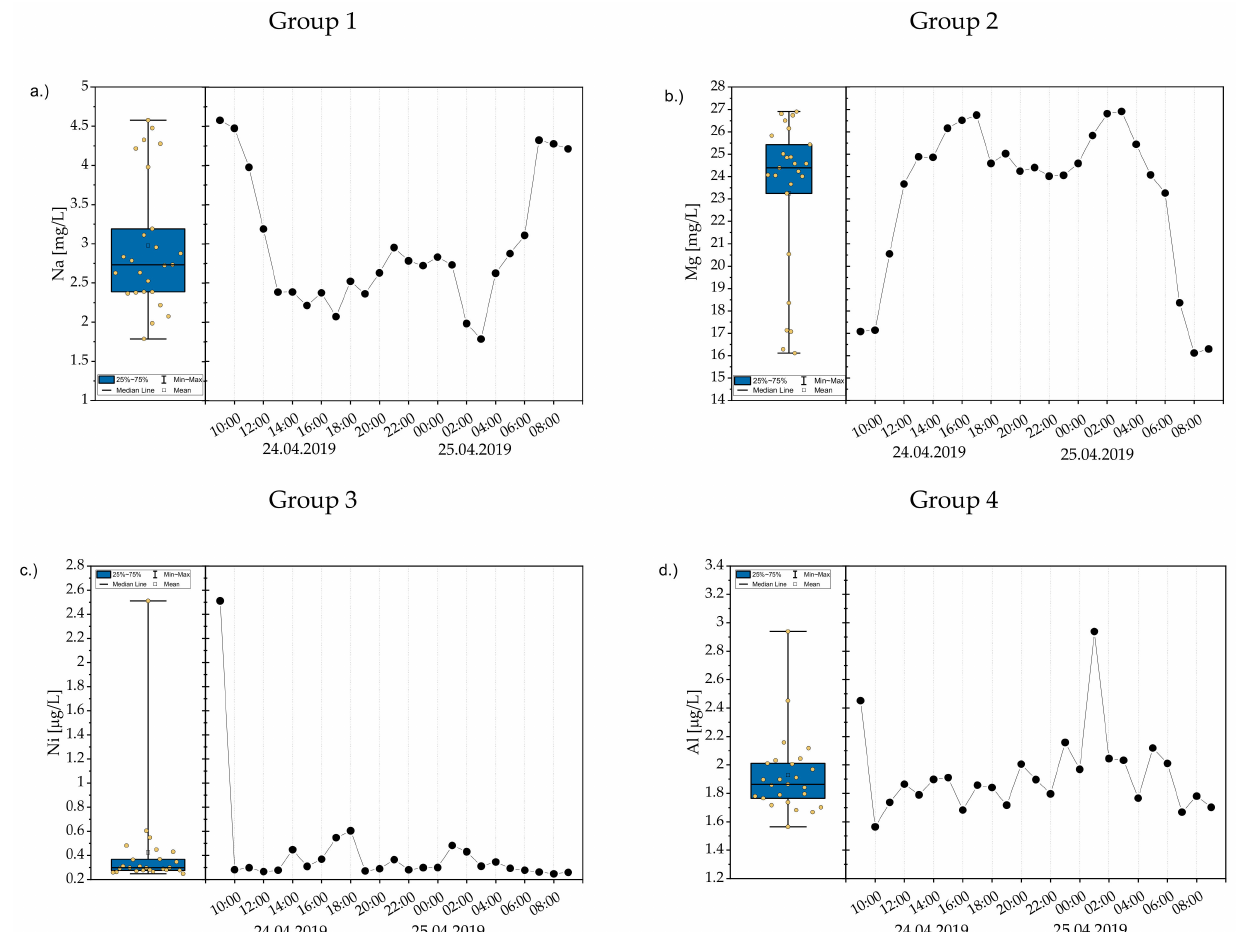
Figure 5. The most representative boxplots and hourly variability of concentrations based on visual observation for Group 1 ( a ), Group 2 ( b ), Group 3 ( c ) and Group 4 ( d